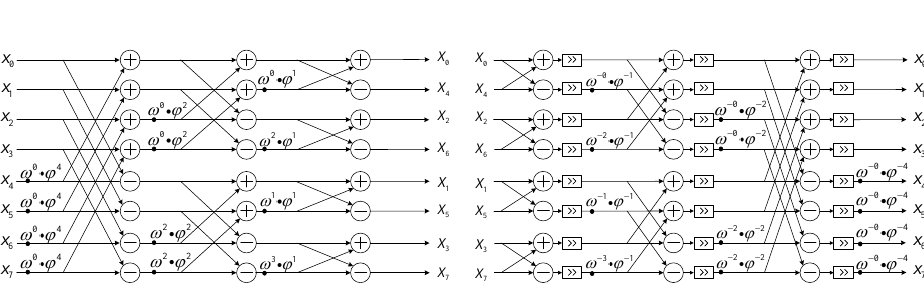
Figure 1: Schematic of rearranged NTT in NWC (left) and INTT in INWC